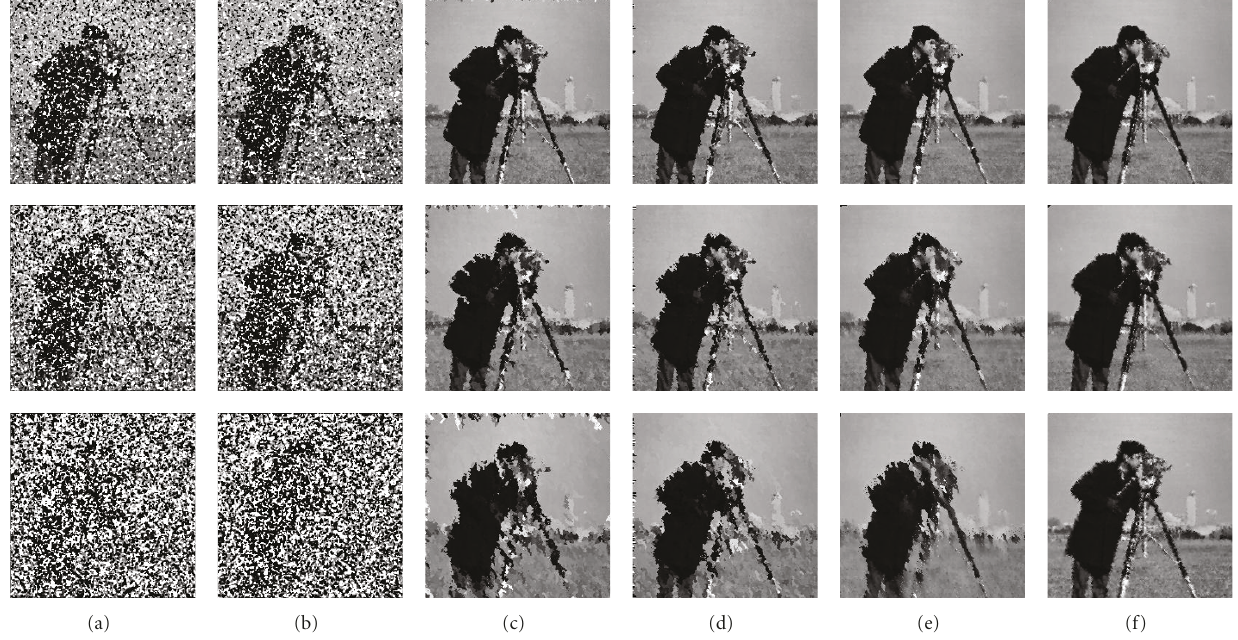
Figure 7: Results of di ff erent filters for Cameraman image. (a) Output of SMF. (b) Output of PSMF. (c) Output of AMF. (d) Output of DBA. (e) Output of REMF. (f) Output of PA. Row 1–Row 3 show processed results of various filters for Cameraman.tif image corrupted by 70%, 80%, and 90% noise